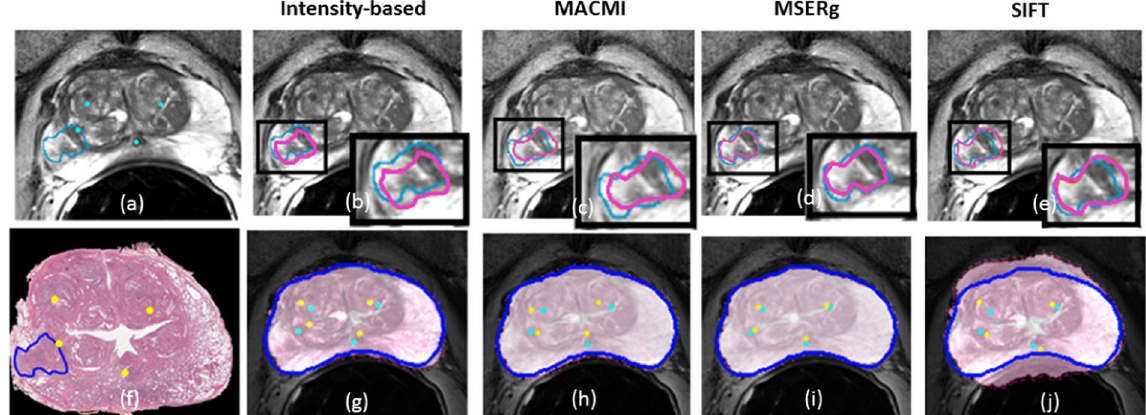
Figure 6. Illustration of a clinical registration case. ( a ), ( f ) are the fixed and moving images with landmarks annotated by the pathologist and the radiologist. The tumor ROI annotations on the pathology image are made by the pathologist and the corresponding tumor ROI on the MRI are mapped from pathology annotations obtained via manual registration. ( b ), ( g ) show the registration results of intensity-based registration; ( c ), ( h ) of MACMI, ( d ), ( i ) of MSERg and ( e ), ( j ) of SIFT, respectively. The light blue lines in panels ( b – e ) illustrate the tumor ROI on a T2-weighted MRI slice and the magenta lines highlight the corresponding ROI on the transformed pathology image. ( g – j ) illustrate the landmark alignment results where the cyan colored landmarks represent those identified on the MRI, while the yellow colored landmarks represent those corresponding locations on the transformed pathology image. The dark blue lines in ( g – j ) illustrate the capsule boundary on